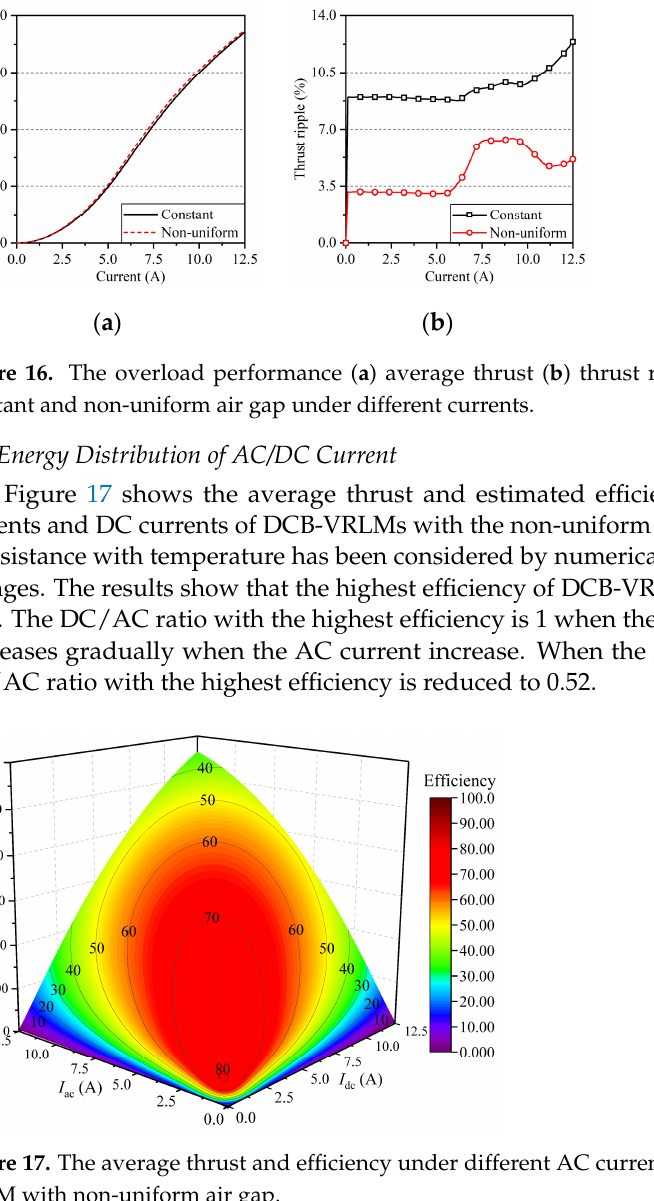
Figure 15. The average thrust performance under different currents.